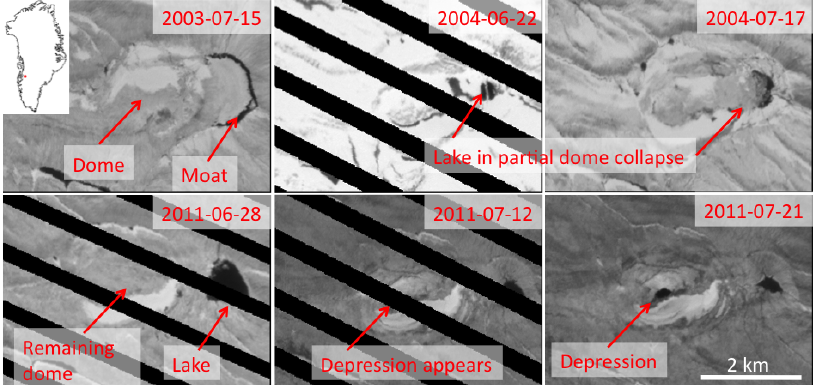
Figure 1. Series of Landsat 7 Enhanced Thematic Mapper Plus panchromatic satellite imagery showing two episodes of the collapse. The 2003 and 2004 images show the formation of a supraglacial lake within a depression on the eastern side of what previously appears to have been a dome edged by a water-filled moat. The 2014 images show the formation of the larger depression within the center of the dome. The black stripes are due to failure of the sensor’s scan line corrector system.